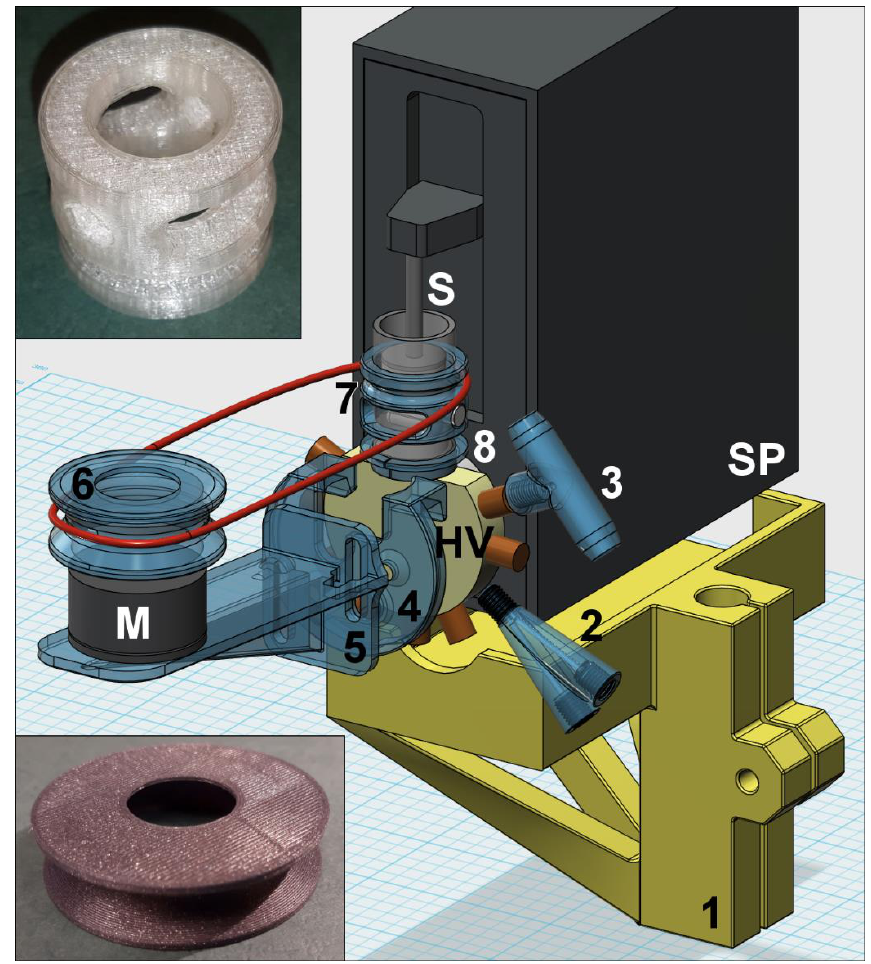
Figure 5. Lab-In-Syringe system from a syringe pump (SP) with nine port head valve (HV) with an upside-down orientated syringe (S). 3D printed elements are shown in blue color and disassembled, required screws are not shown. The syringe is situated on a laboratory stand compatible support (1).